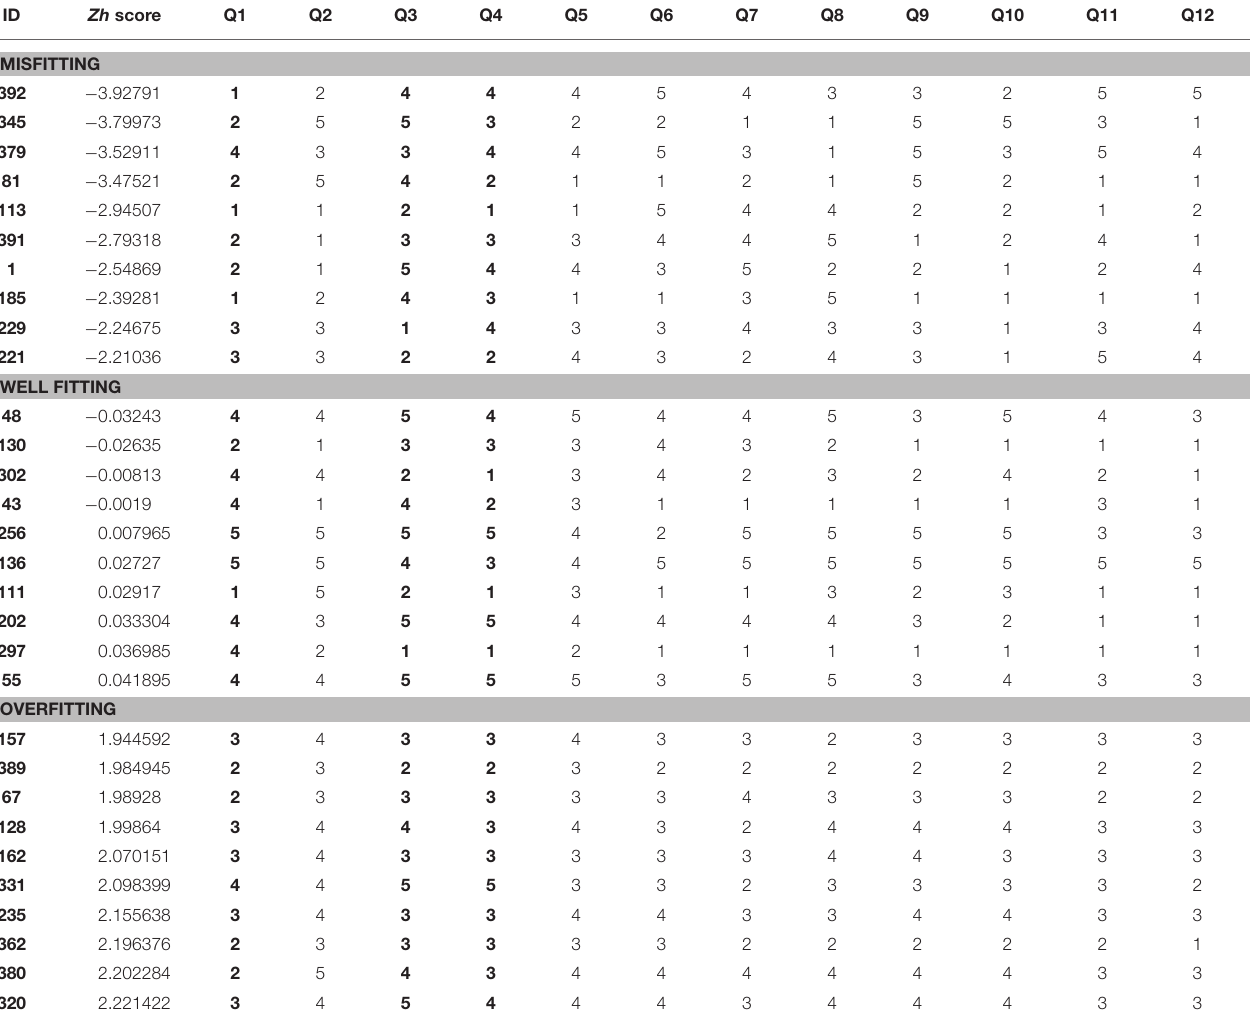
Bold font represents items relating to the second factor. Zh-values can be interpreted using the z-scale distribution. For example, a respondent with a Zh-value of − 1 shows a response pattern that deviates from the average response by one standard deviation. In addition, a respondent with − 2 indicates his or her response deviates by two standard deviations from the average response